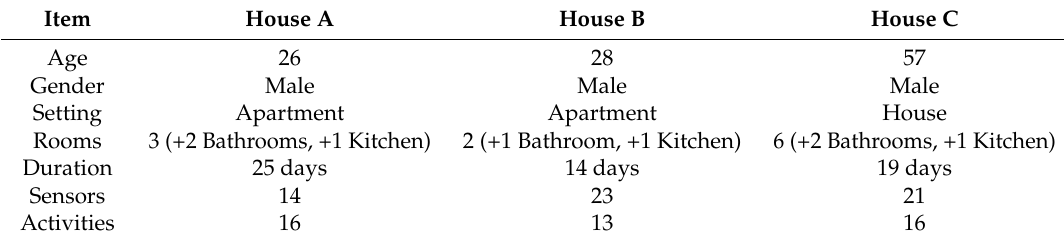
Table 2. Characteristics of the publicly available dataset that was used to evaluate the new approach of ADL detection. Three different datasets are used: Houses A, B and C.